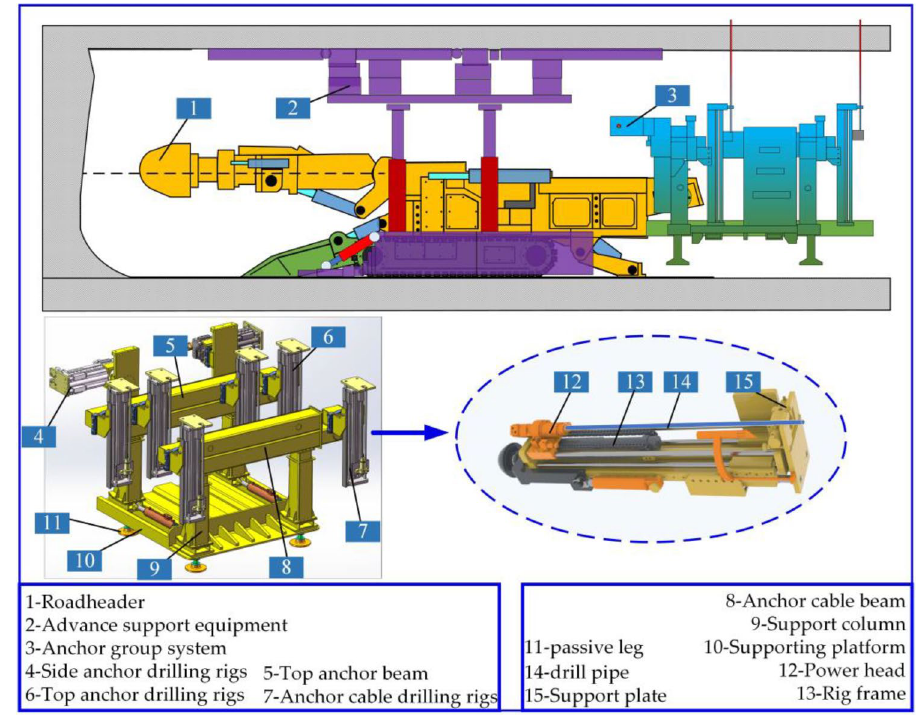
Figure 1. Equipment composition diagram of driving, supporting and anchoring combined